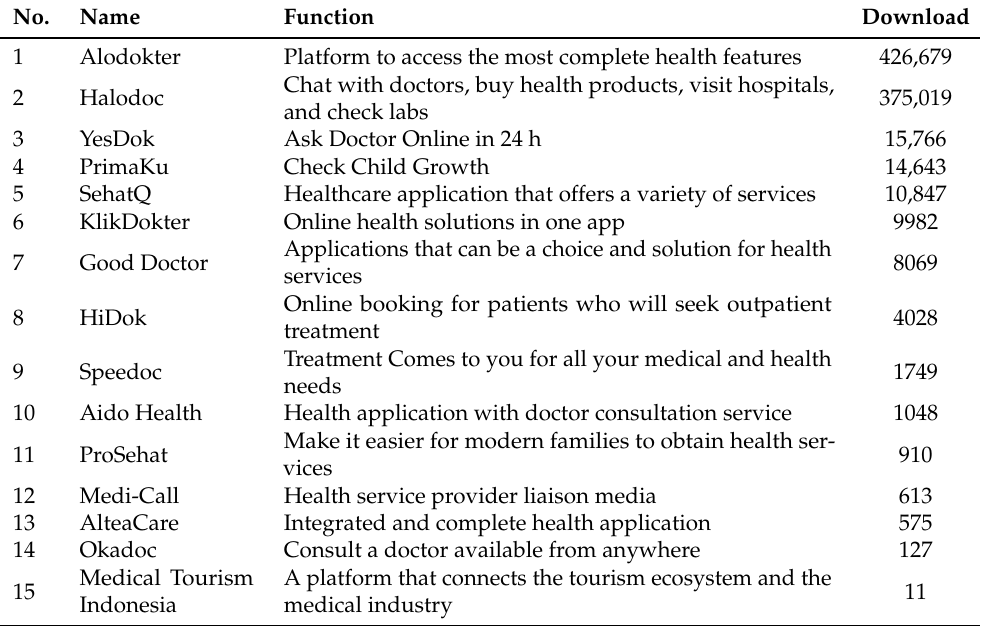
Table 2. Medical application start-ups in